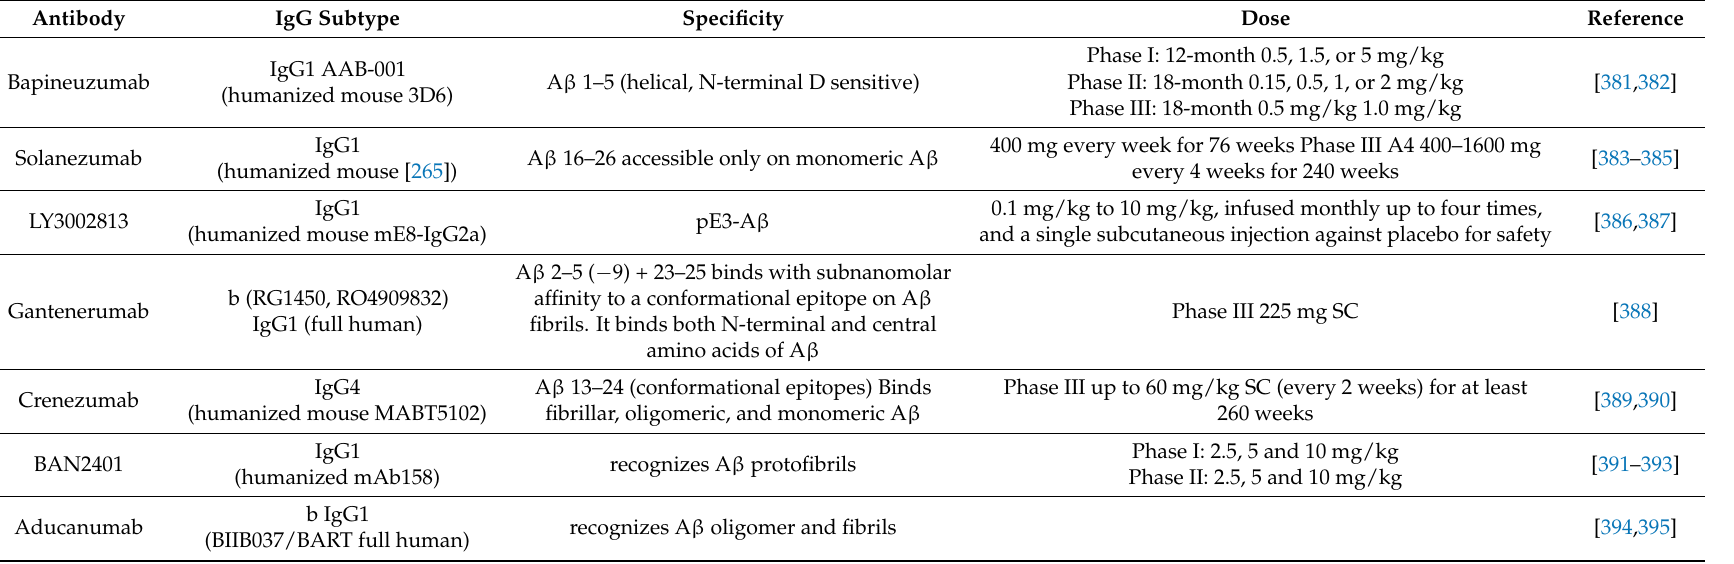
Table 2. Summary of monoclonal antibodies under clinical trials.